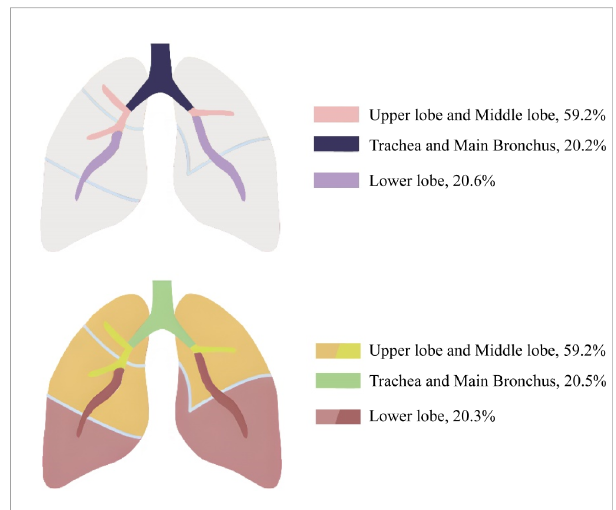
FIGURE 1 Distribution of new lesions in the lung and tumor location in the cancer